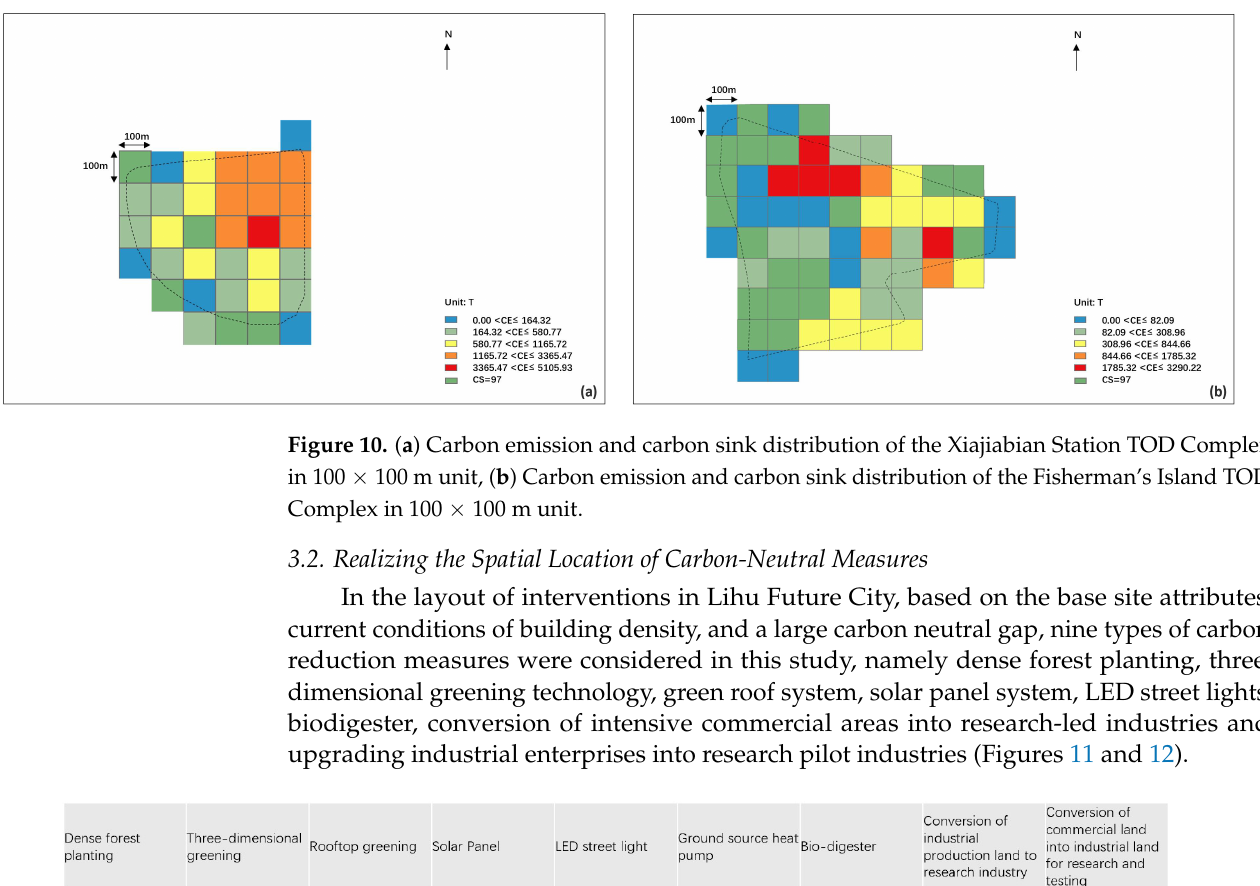
Figure 10. ( a ) Carbon emission and carbon sink distribution of the Xiajiabian Station TOD Complex in 100 × 100 m unit, ( b ) Carbon emission and carbon sink distribution of the Fisherman’s Island TOD Complex in 100 × 100 m unit.